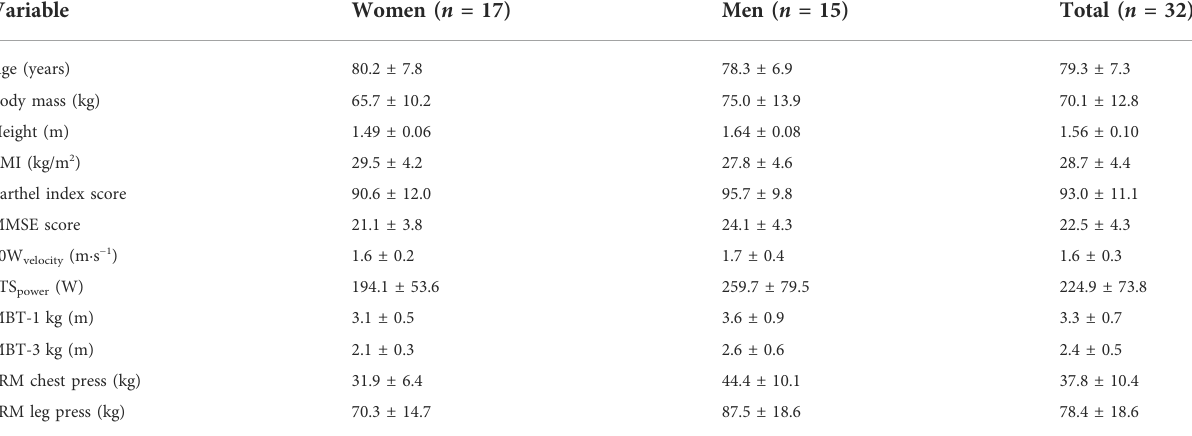
TABLE 1 Participants ’